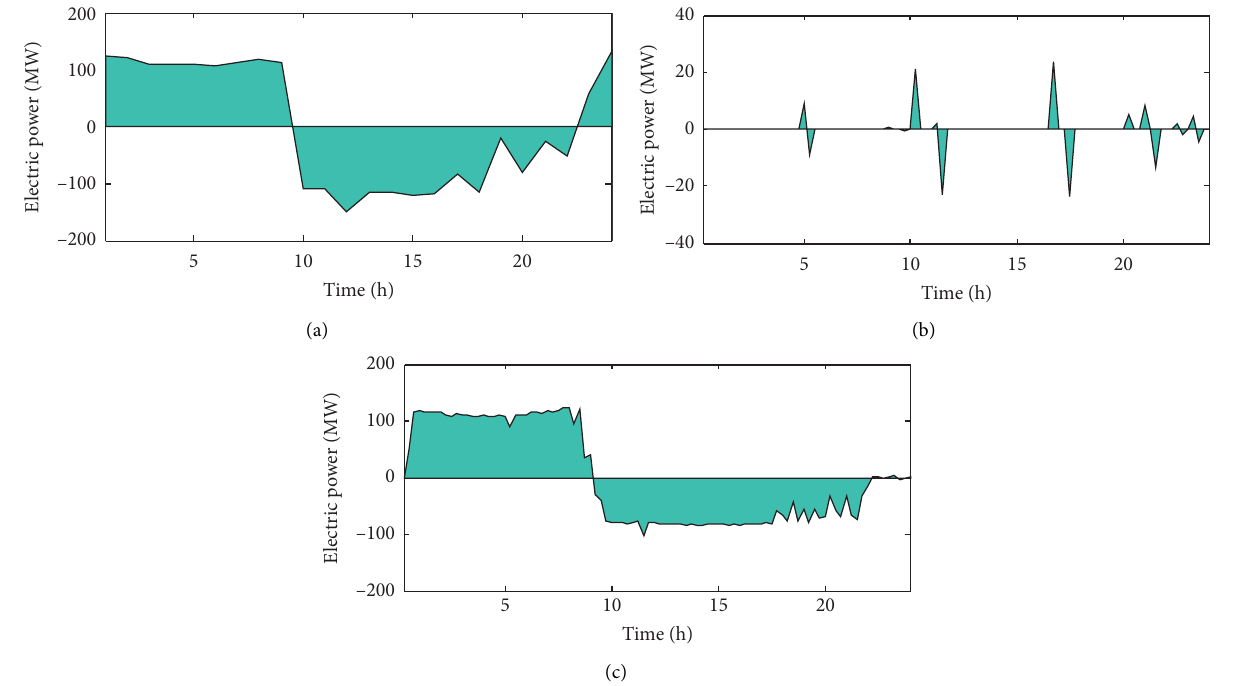
Figure 6: Scheduling results of shiftable load. (a) Method 1. (b) Method 2. (c) Method 3 (the proposed method).